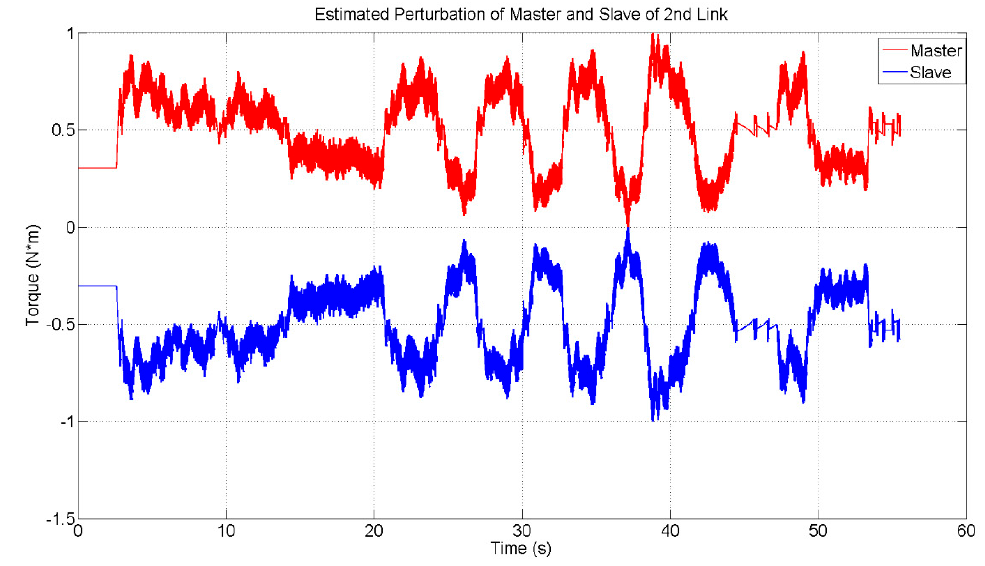
Figure 20. Normalized estimated perturbation of master and slave for 2nd link.